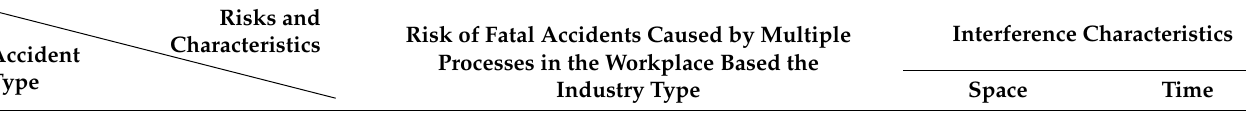
Table 9. Risks and characteristics of multiple processes in the workplace based on the accident